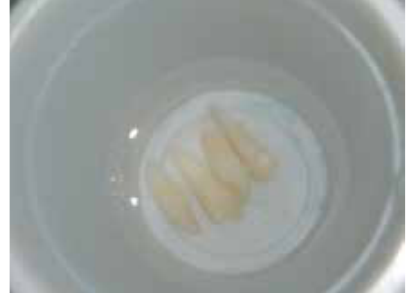
Fig 2. Avulsed teeth